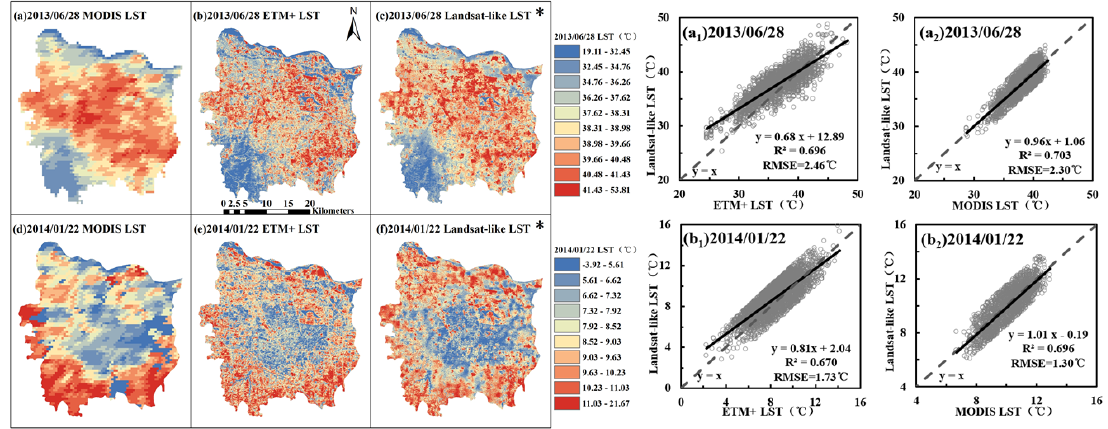
Figure 3. Comparison between MODIS / Landsat LST and “Landsat-like” LST in 28 June 2013 and 22 January 2014.